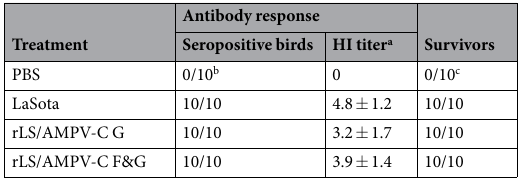
Table 3. Serum antibody response against NDV following vaccination and survival of turkeys after challenge with a lethal dose of NDV/CA02. a Hemagglutination inhibition (HI) titer was expressed in log 2 of the mean ± standard deviation. b Number of seropositive birds/total number of birds tested. c Number of died birds/ total number of birds